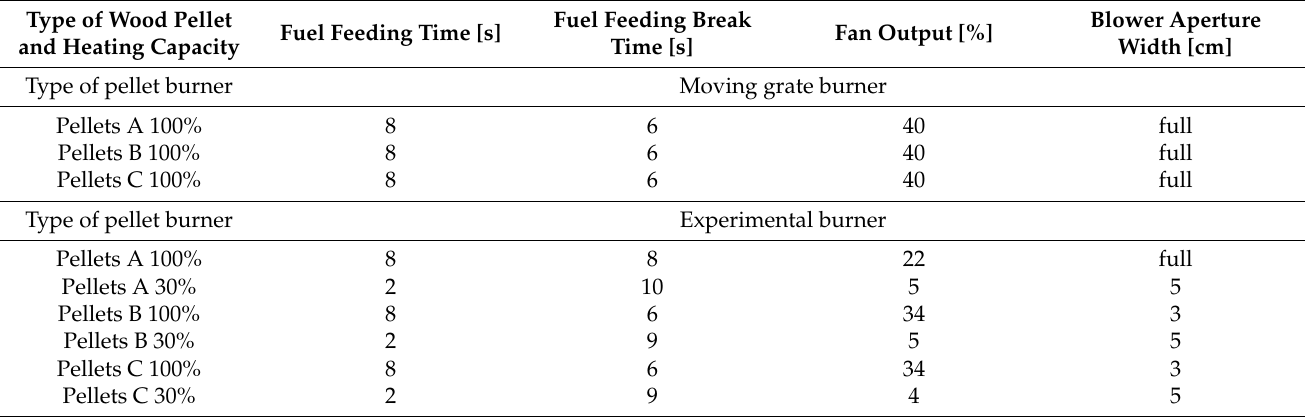
Table 3. Boiler settings during combustion; full and minimal